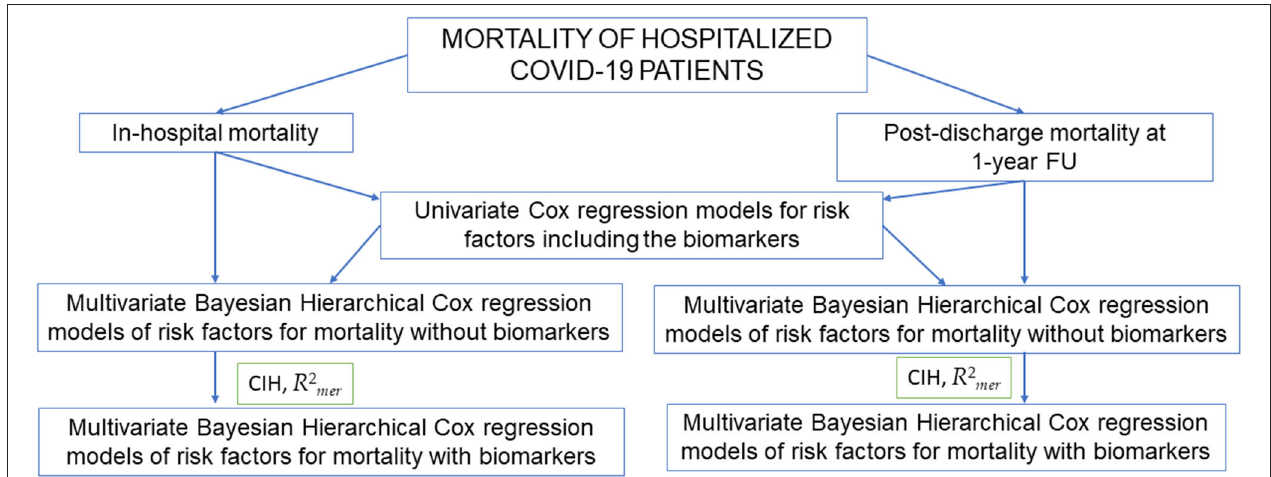
FIGURE 2 | Mathematical model of the statistical analyses. ST2, soluble suppression of tumorigenicity 2; VCAM-1, vascular cells adhesion molecule-1; TnI, high sensitive troponin